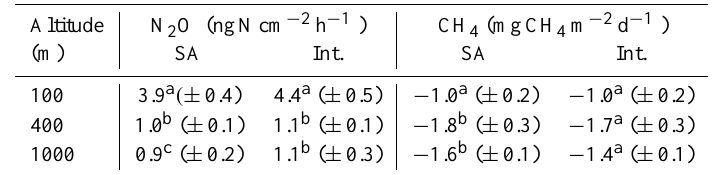
Table 5. Simple annual mean (SA) and integrated (Int.) fluxes of N 2 O and CH 4 for different altitudes. Different letters represent statistically significant differences among the altitudes. See text for a description of the averaging and integration